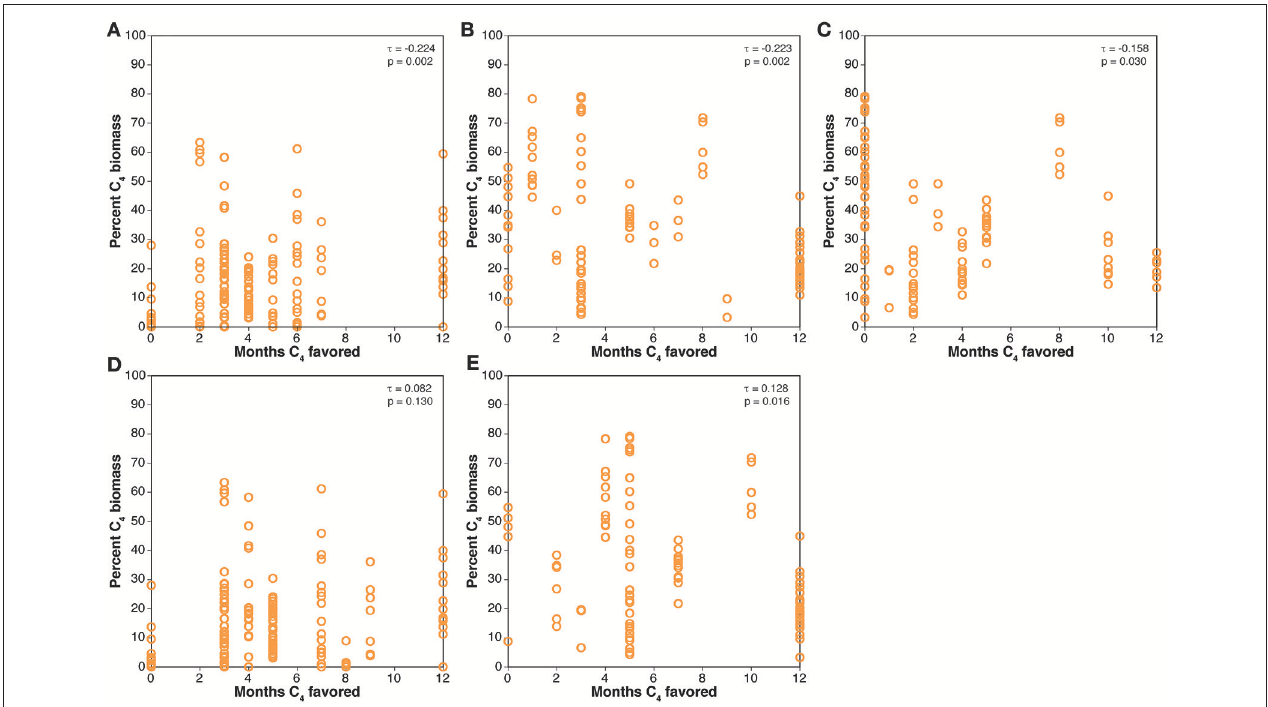
FIGURE 4 | Comparisons of results of the crossover temperature model to mean estimated percent C 4 biomass from the paleosol carbonate compilation. (A) Pliocene, 280 ppmV CO 2 . (B) Pliocene, 405 ppvM CO 2 . (C) Pliocene, 560 ppmV CO 2 . (D) Miocene, 280 ppmv CO 2 . (E) Miocene, 401 ppmV CO 2